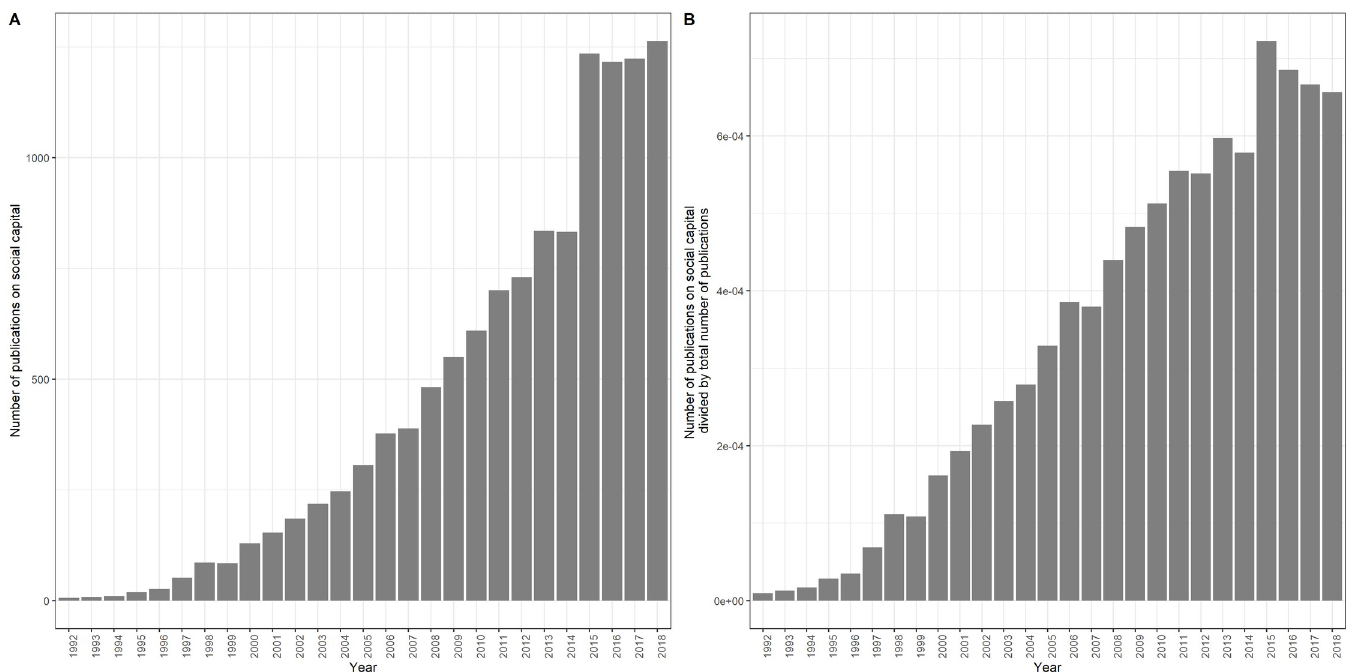
Fig 1. Absolute and relative frequency of publications on social capital by the year of